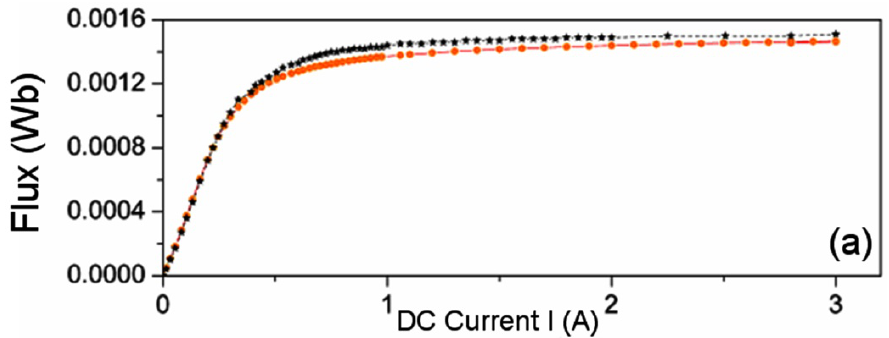
Figure 12. Results for the E47/20/16 ferrite core. ( a ) Φ - I curves and ( b ) L - I curves. Experiment (– * –) and 2D simulations (–  –) with g = 4